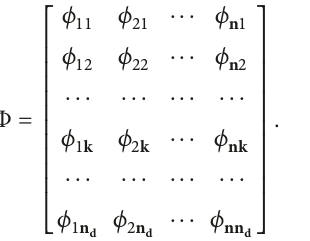
Figure 3: The factors influencing the performances of antenna